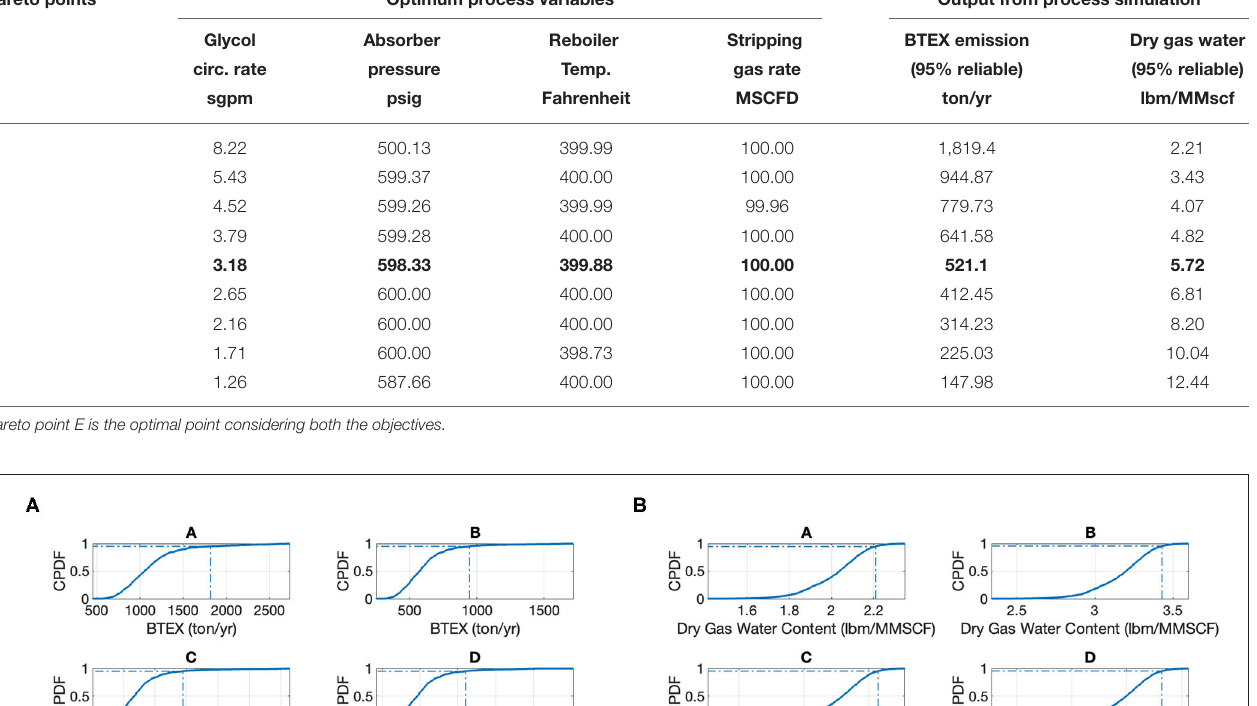
TABLE 3 | Optimized process condition for the nine Pareto points. Pareto points